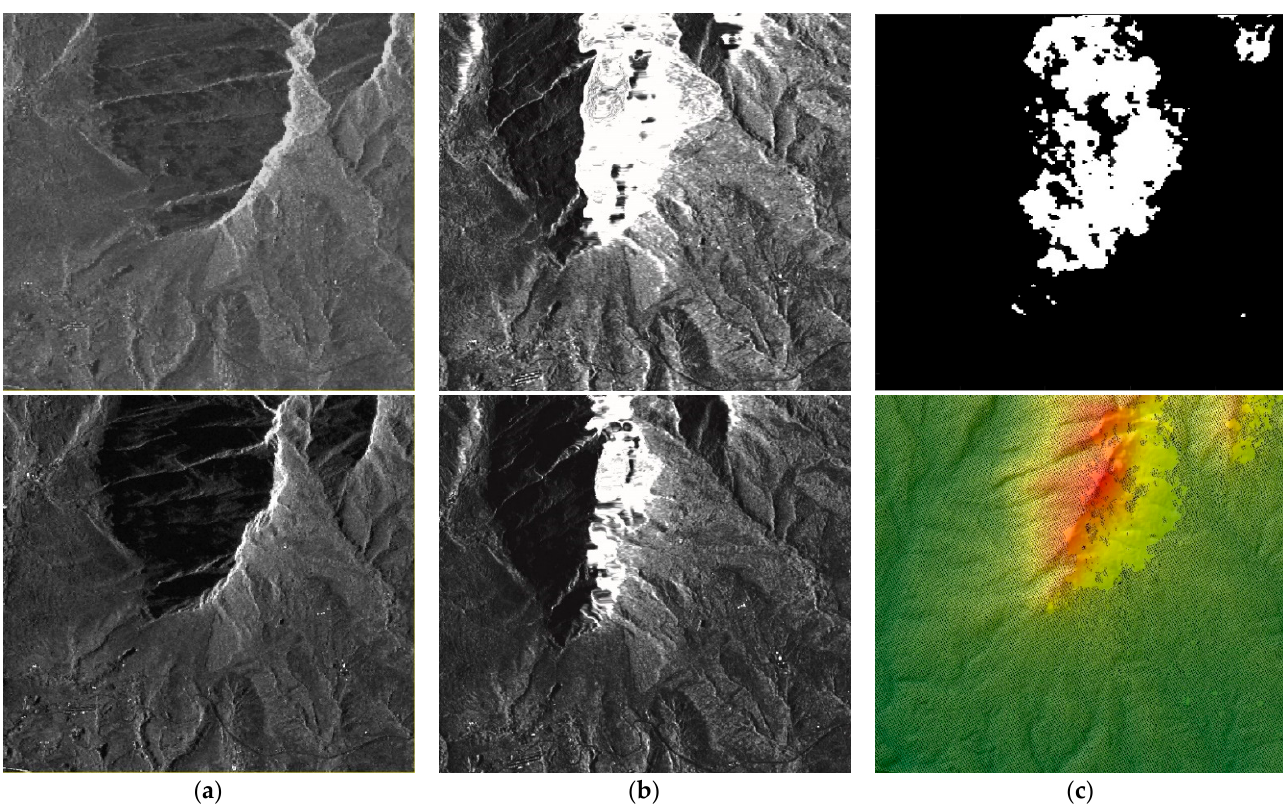
Figure 9. ( a ) Amplitude image subset of SL_0925 and SL_1001; ( b ) Epipolar image subset of SL_0925 and SL_1001; ( c ) subset of the Spotlight mode disparity map derived by SGM_gray (Black colors represent valid disparity values; White color represents invalid disparity values); Geographic points generated from the disparity map overlaying on the reference DSM.